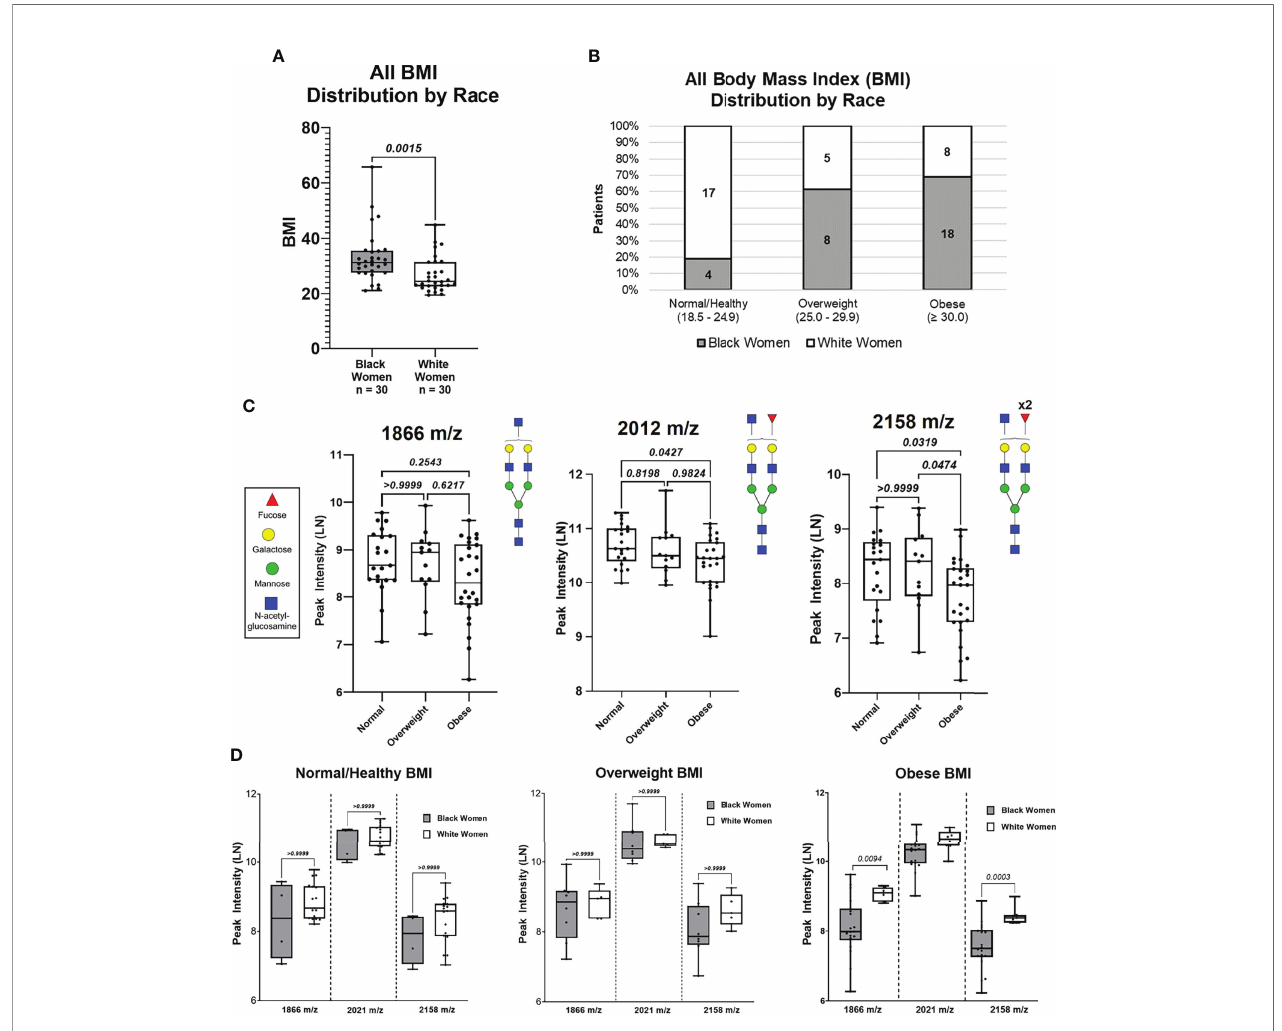
FIGURE 3 | N-Glycan peak intensify analysis based on BMI (Normal, Overweight and Obese) of all patients. (A) Distribution of patient BMIs between Black women and White women cohorts. (B) Distribution of Black women and White patients based on BMI categories: Normal (18.5 – 24.9). Overweight (25.0 – 24.9), and Obese ( ≥ 30.0). (C) Comparing peak intensi fi es between BMI categories for N-glycans 1866 m/z and 2158 m/z based on BMI